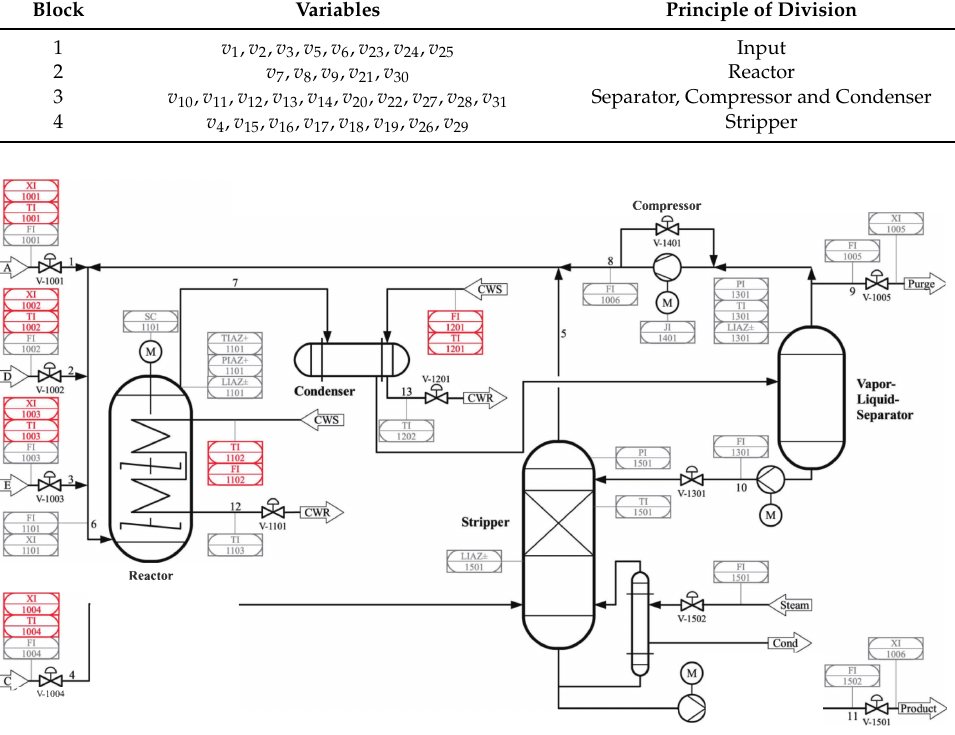
Figure 7. Structural schematic diagram of TE